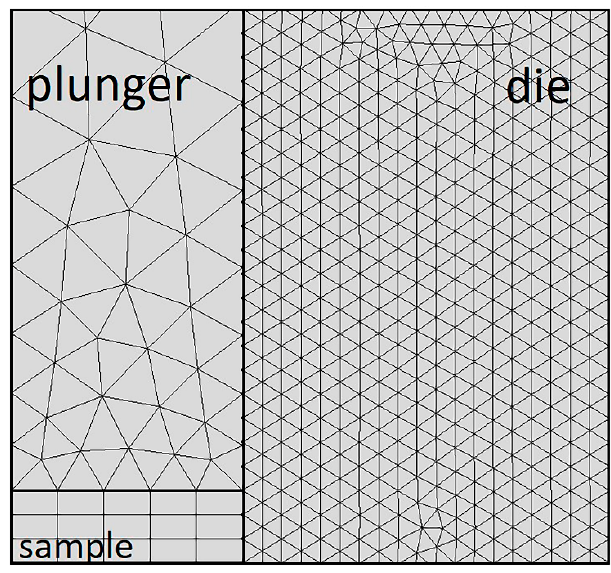
Figure 4. The mesh on the setup model fragment.